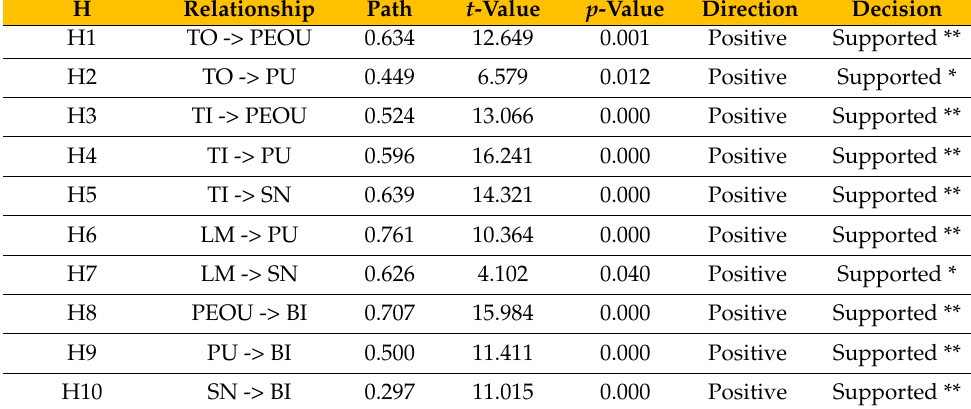
Table 7. Hypotheses testing of the research model (significant at p ** < = 0.01, p * <